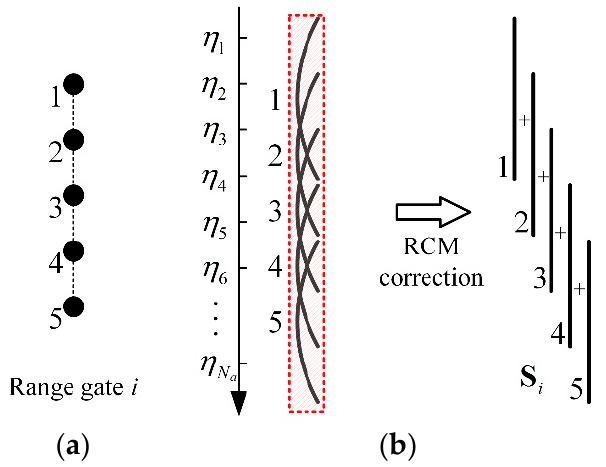
Figure 7. Illustration of the extraction of S i . ( a ) Diagram of the i th range gate, where each point represents a pixel. ( b ) Illustration of the RCM correction of the compressed echo of the i th range gate.